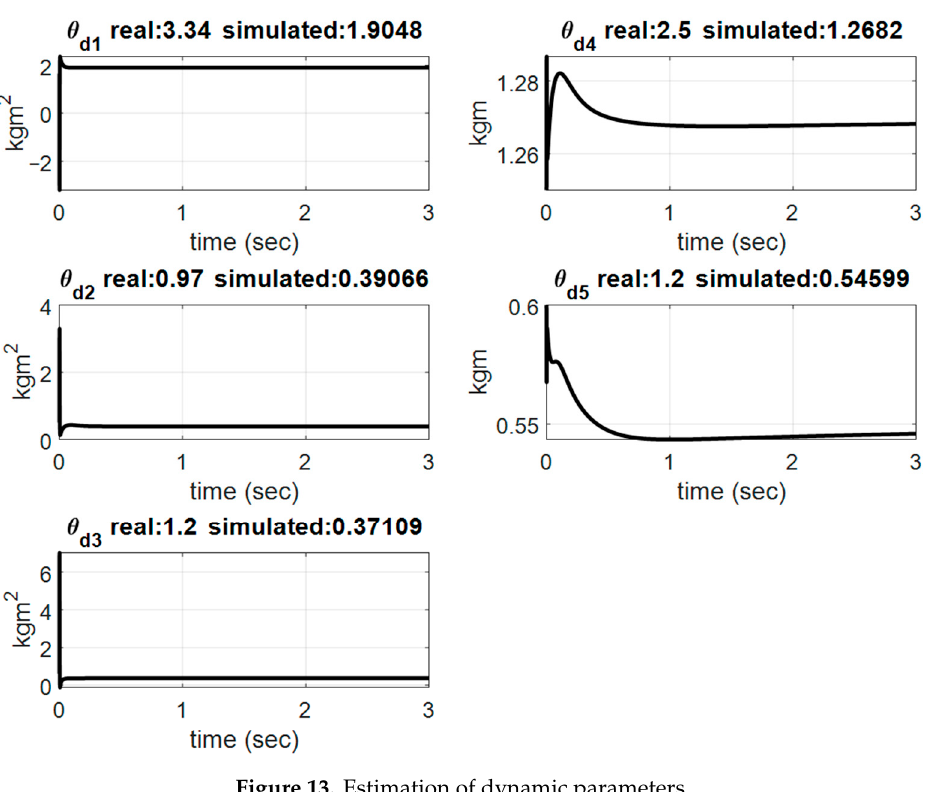
Figure 13. Estimation of dynamic parameters.